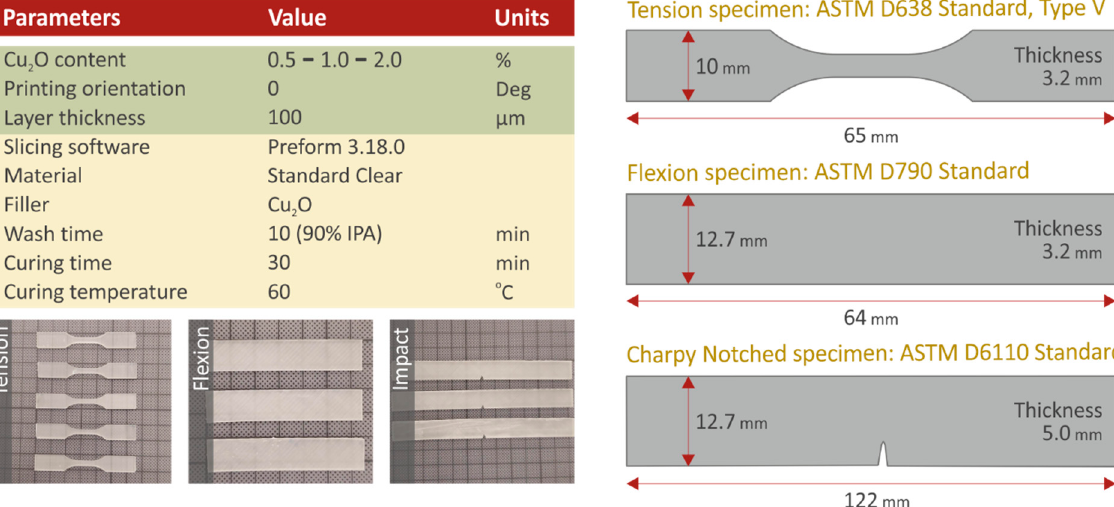
Figure 1. Fundamental SLA 3D printing settings, pictures, and sketches of the 3D printed